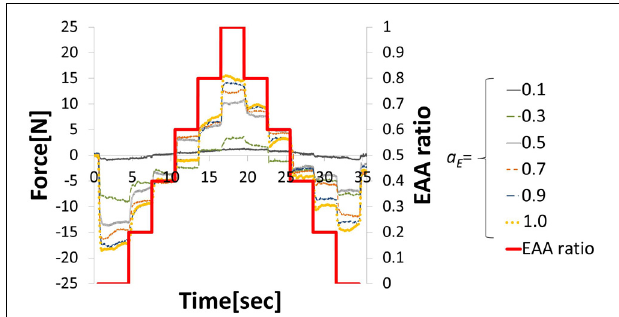
FIGURE 3 | Hand force for various levels of EAA